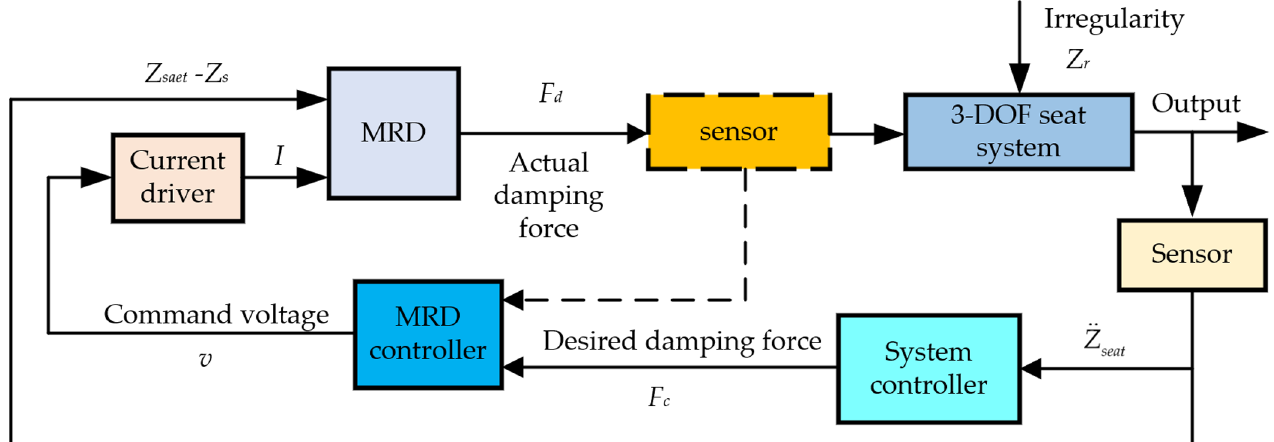
Fig. 1. Semi-active seat suspension control